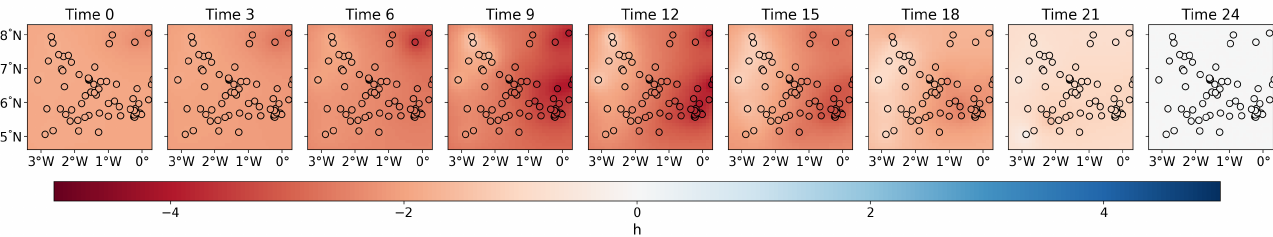
Figure 8. Mapping T t for each node of the pixel grid (background) and at the station locations (circles) at the 9 times of the warping grid. In red, the mapping is pushing the time series forward in time. In blue, the time series is pushed